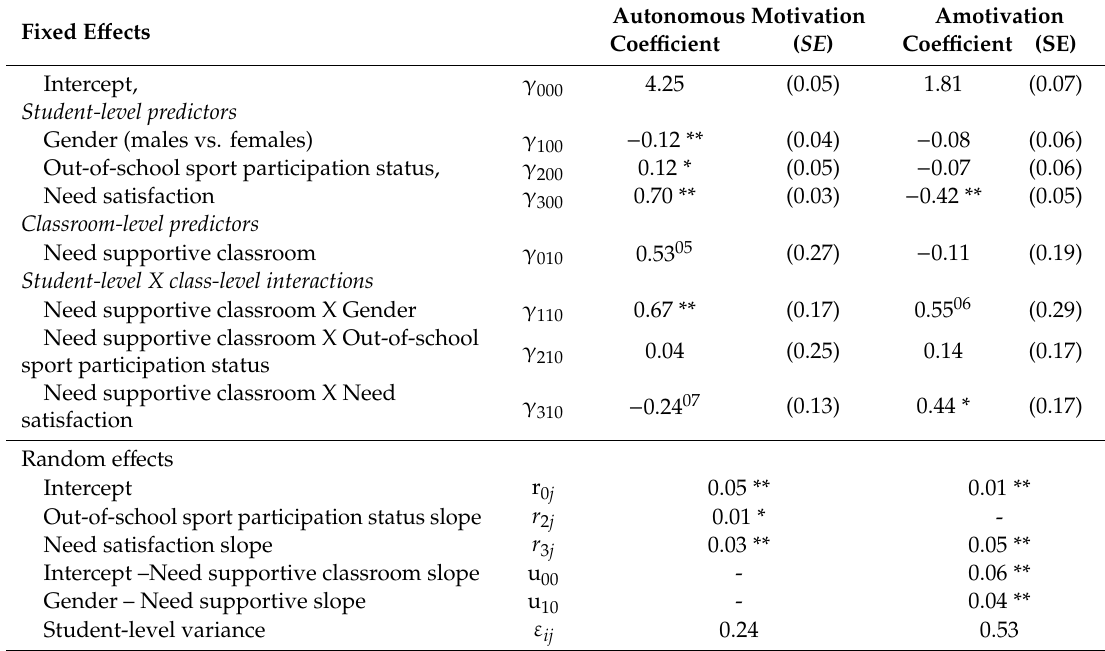
Table 2. The multilevel model predicting autonomous motivation and